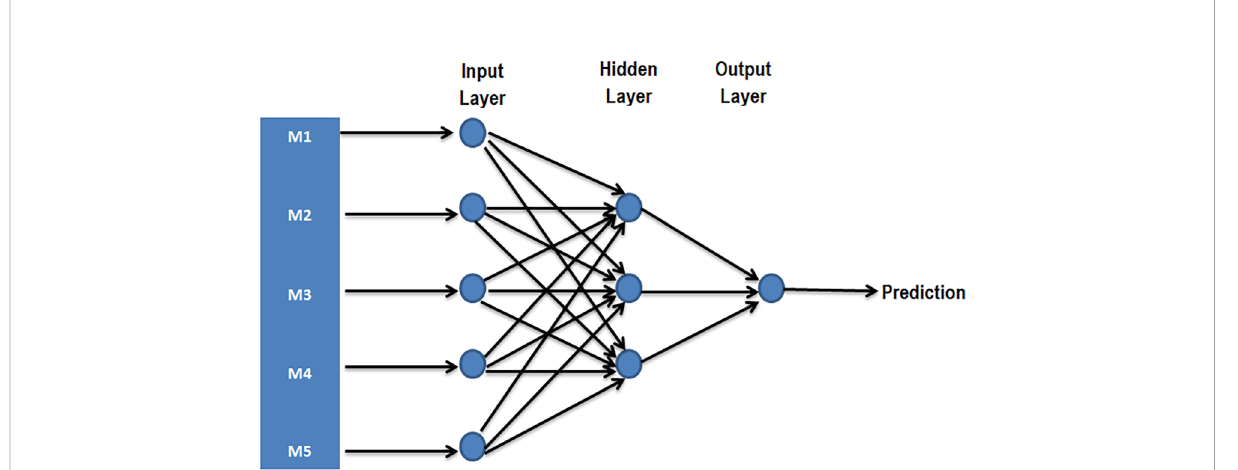
FIGURE 5 A simple case possibility of prediction with neural network with a single hidden layer [inspired by McDowell (2016)]. As part of GS, the input layer represents one neuron for each molecular marker (SNP markers, for example, M1, M2, M3, M4, and M5), whereas the output represents single neuron combining information necessary to predict the phenotype or